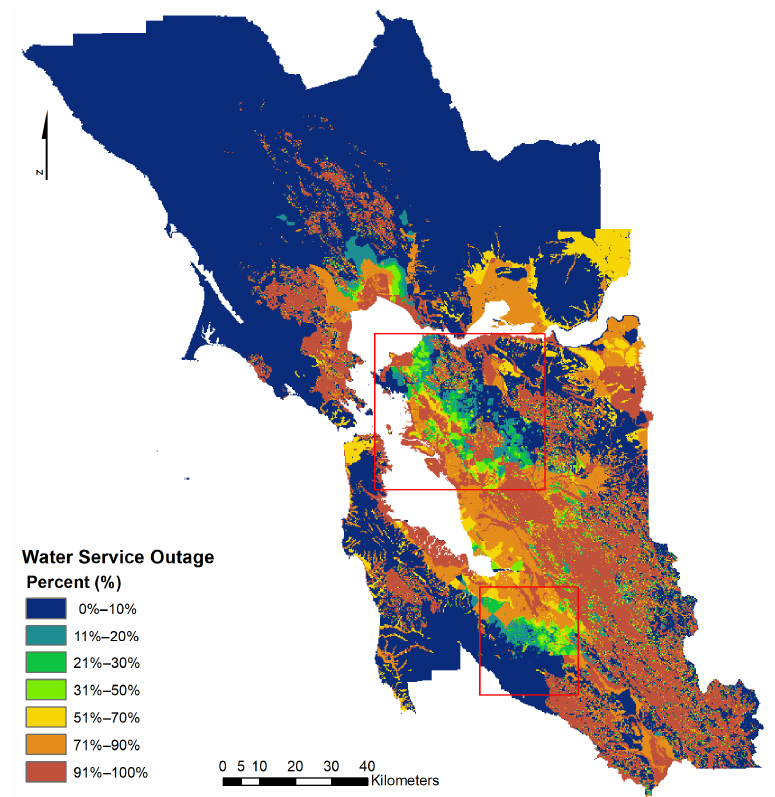
Figure 8. Water service outage calculation from the serviceability index. An estimate of households (and residents) with potable water service outage in the HayWired scenario was calculated through the risk equation (Equation (9)) and mapped in Figure 9, throughout the nine-county HayWired study region. Expanding estimates of water pipeline break rates and potable water service outages identified additional areas (Table 2) in Fremont (Alameda County) and the eastern part of San Jose (Santa Clara County), along with areas in eastern Alameda and Contra Costa Counties, Marin County, San Mateo County and San Francisco with potential emergency water resource requirements that were not originally identifiable in the HayWired CUWNet analysis. Table 2. Summary of results in the nine-county HayWired scenario study region. County